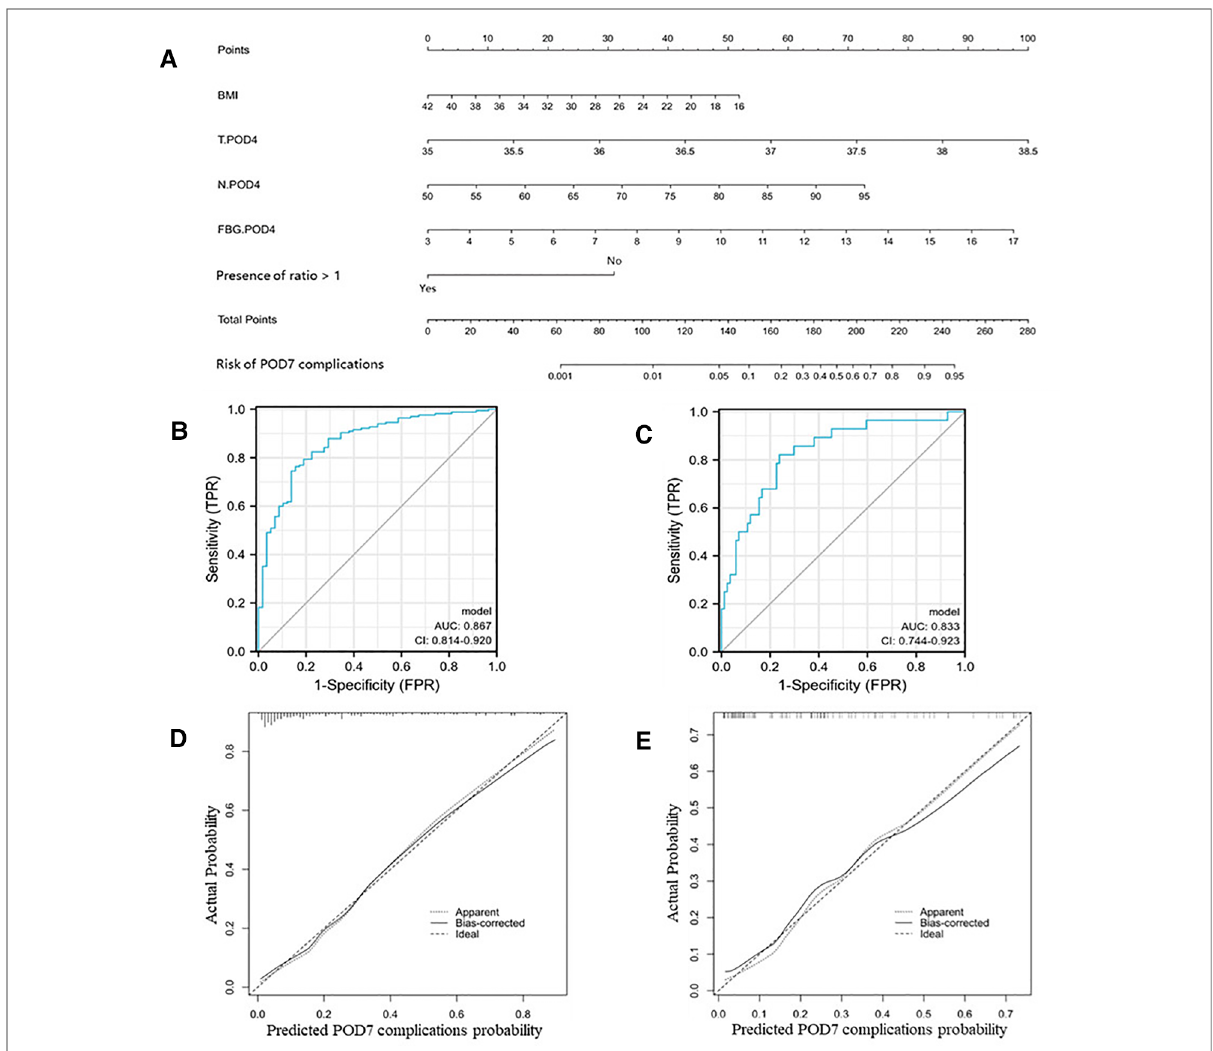
FIGURE 1 Nomogram-A and performance of the nomogram. ( A ) The possibility of POD7 complication was estimated by summing the scores corresponding to each risk factor. ROC and calibration curves of the nomogram for the probability of POD7 complication in the training set ( B , D ) and the validation set ( C,E ). In the calibration curve, the y -axis represents the probability of actual POD7 complication occurring and the x -axis represents the predicted probability. The wide dashed line represented a perfect prediction of the ideal model, and the solid line represented the actual performance of the Nomogram-A. The closer they were, the better the prediction